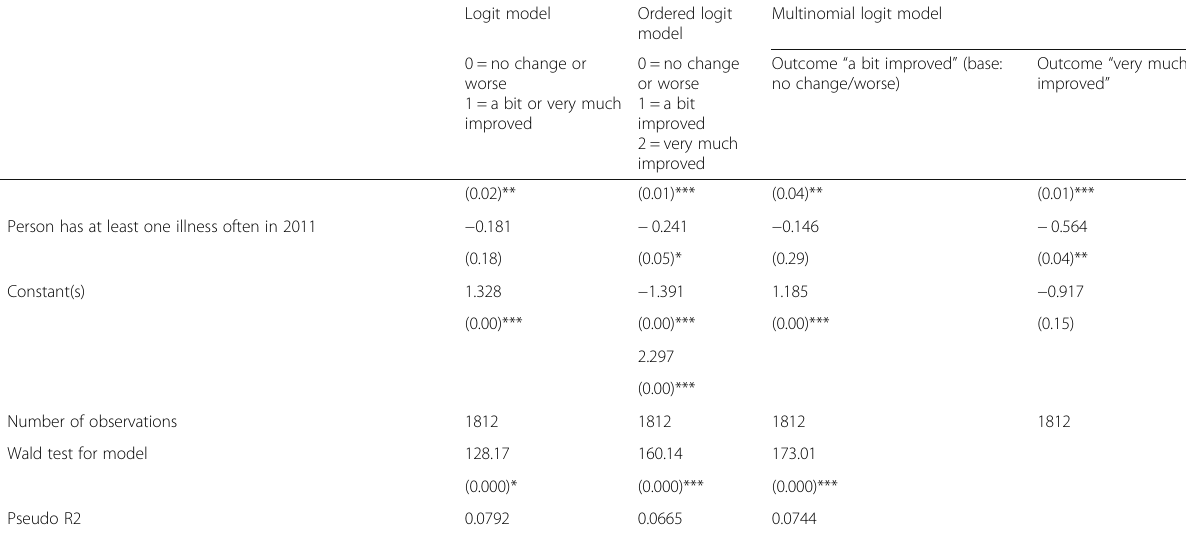
Table 2 Results from multivariate analyses. Estimated coefficients (Continued)